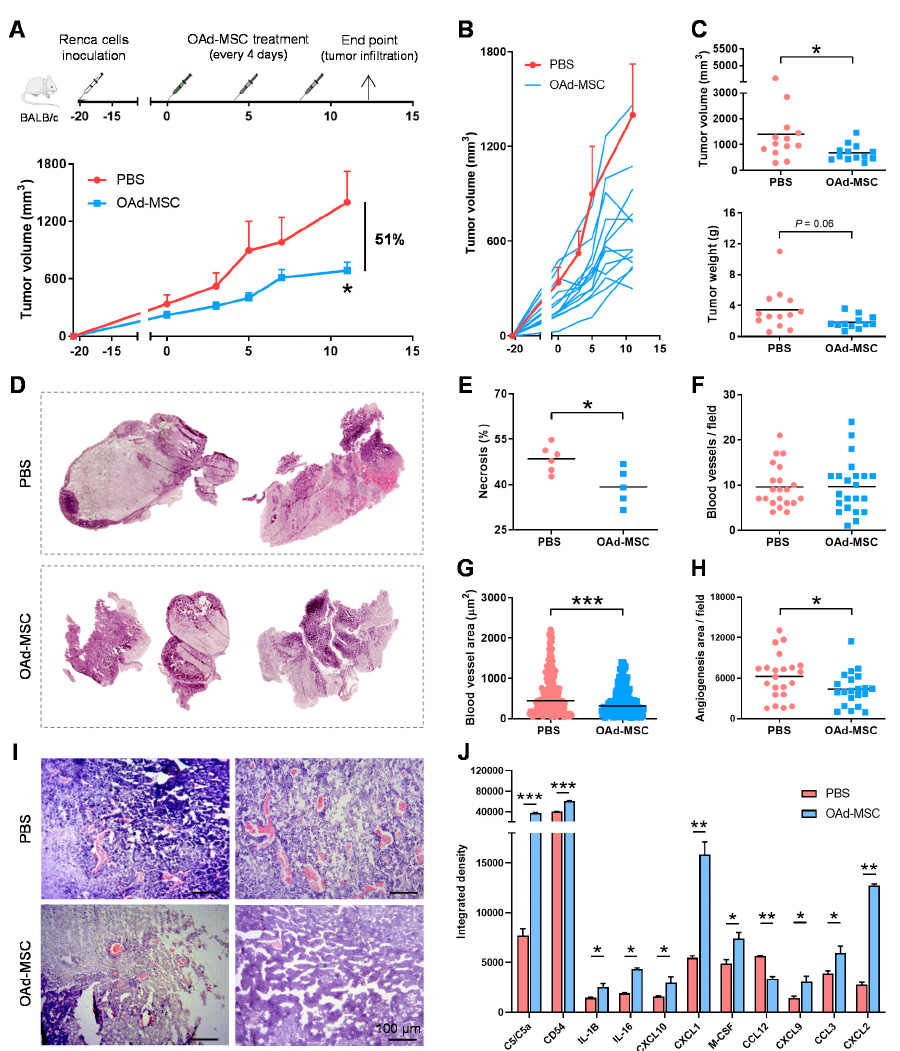
Figure 3. In vivo antitumor efficacy of OAd-MSCs in a mouse model of renal adenocarcinoma. ( A ) Graph represents the experimental design and antitumor effect of OAd-MSCs in BALB/c mice bearing subcutaneous Renca tumors. Lines represent the mean + standard error of the mean (SEM) of the tumor volume in groups treated with PBS (red; n = 13) and OAd-MSCs (blue; n = 12) (Mann–Whitney U test). ( B ) Follow-up of tumor volume in mice treated with OAd-MSCs (individual values, blue lines) and the control group (mean + SEM, red line). ( C ) Tumor volume and weight of groups treated with PBS and OAd-MSC at end point (Mann–Whitney U test). ( D , E ) Necrosis was quantified in hematoxylin- and eosin-stained sections from control and treated tumors ( n = 5–6). ( F – H ) Angiogenesis was studied by ( F ) quantification of number of tumor blood vessels per field, ( G ) area per blood vessel, and ( H ) total angiogenesis area per field ( μ m 2 ) (Mann–Whitney U test). ( I ) Representative images of hematoxylin- and eosin-stained sections from control and treated tumors. ( J ) Quantification by integrated density of pro-inflammatory cytokines differentially expressed in tumors treated with PBS (red) or OAd-MSC (blue) (unpaired t -test). * p < 0.05, ** p < 0.01, *** p < 0.001.